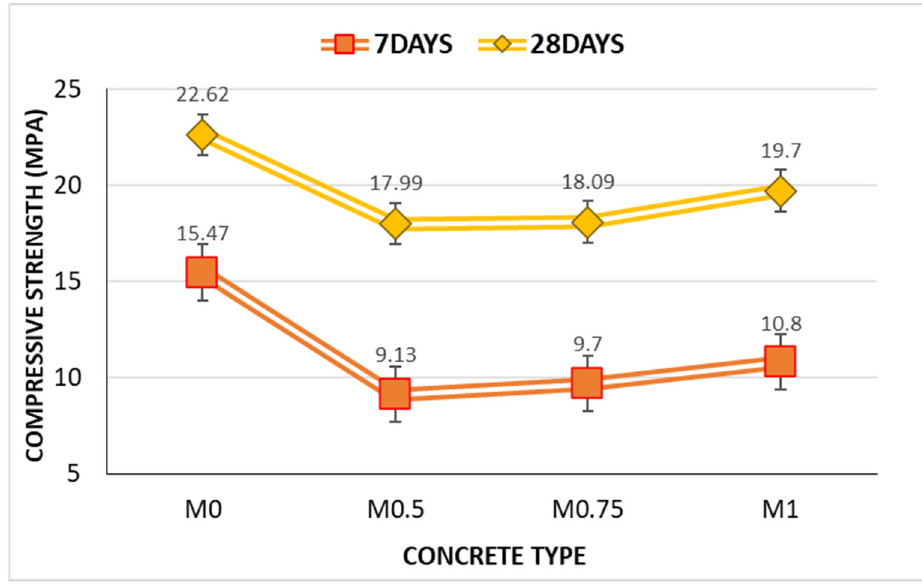
Figure 11. Compressive strength results for various types of SCC mixes.